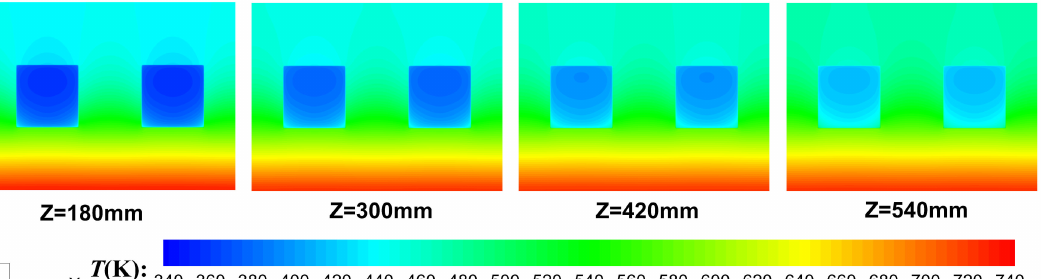
Figure 12. Temperature distribution of the cooling panel and kerosene in the cross